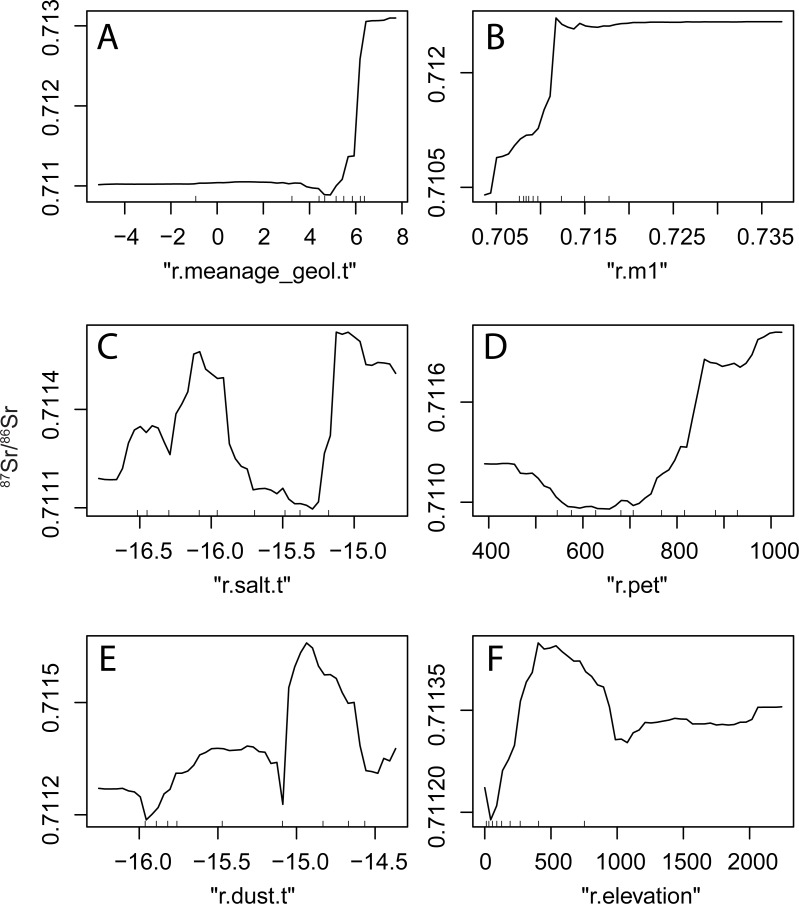
Partial dependence plots for some important variables.A. Log-transformed maximum age of geological units (R.meanage_geol.t) from GLiM database (r.meanage_geol.t in Table 2), B. Median prediction of Bataille et al. (2014)’s model applied to Western Europe (r.m1 in Table 1), C. Log-transformed values of Sr flux from sea salt aerosol deposition in t.km-2.a-1 (r.salt.t in Table 2), D. Potential Evapo-transpiration (r.pet in Table 2), E. Log-transformed values of Sr flux from dust aerosol deposition (r.dust.t in Table 2) and F. Elevation (r.elevation in Table 2). Refer to Tables 1 and 2 for description and sources of each covariate. Hash marks along the x axis show covariate sample decile values.